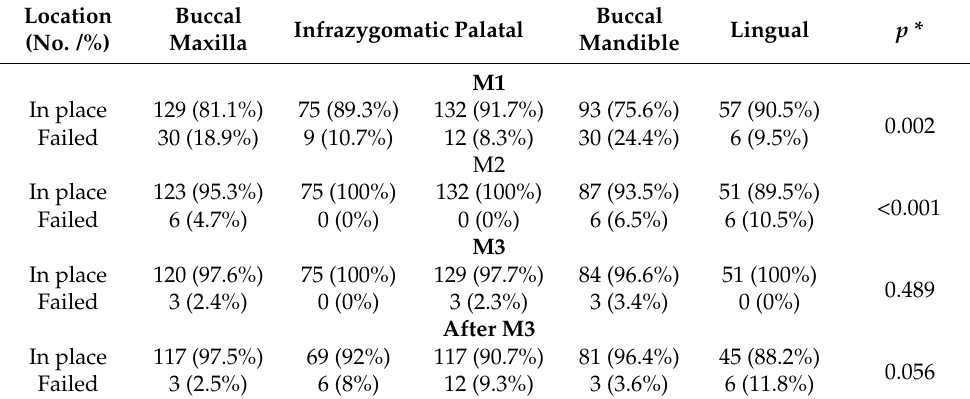
Table 3. Distribution of the mini-implants according to the location and the rejection rate in M1, M2, M3 and after